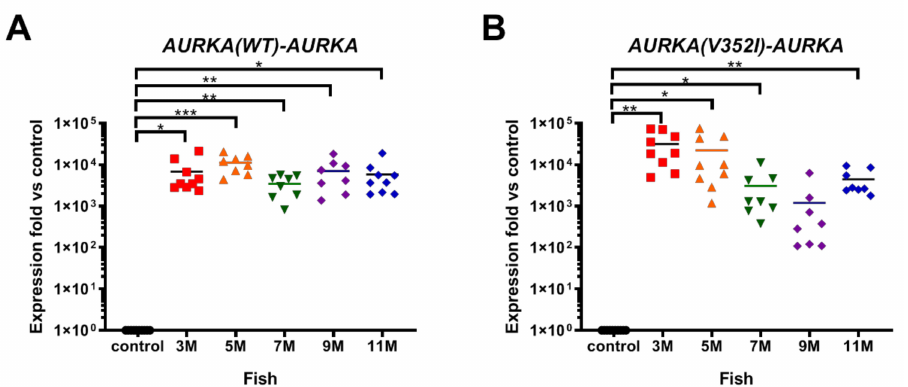
Figure1. ExpressionofAuroraAkinase(AURKA)inAURKA(WT)andAURKA(V352I)transgeniczebrafish compared with control fish. qPCR analysis of AURKA in transgenic zebrafish ( A ) Tg(fabp10a:AURKA(WT)- EGFP-mCherry, myl7:EGFP); ( B ) Tg(fabp10a:AURKA(V352I)-EGFP-mCherry, myl7:EGFP). Expression fold compared to control fish (Tg(fabp10a:EGFP-mCherry) is shown in red (3 M), orange (5 M), green (7 M), purple (9 M), and blue (11 M). Statistical analysis of these results was performed using a two-tailed Student’s t -test. Asterisks (*) represent the level of significance. * p -value ≤ 0.05; ** p -value ≤ 0.01; *** p -value ≤